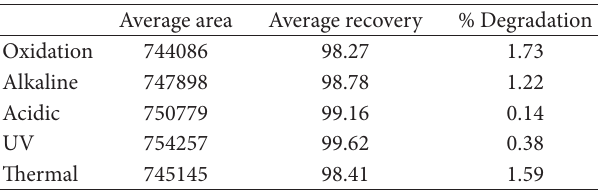
T 7: Results of quetiapine fumarate exposed to different path- ways.